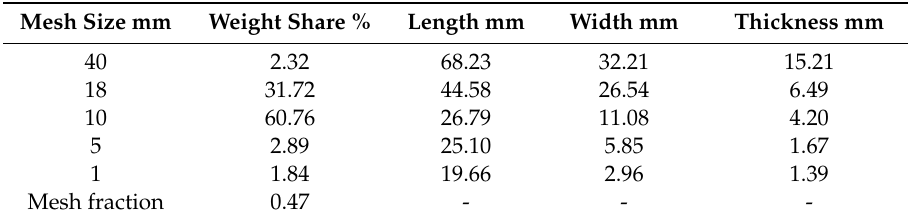
Table 2. Sawdust dimensional analysis.